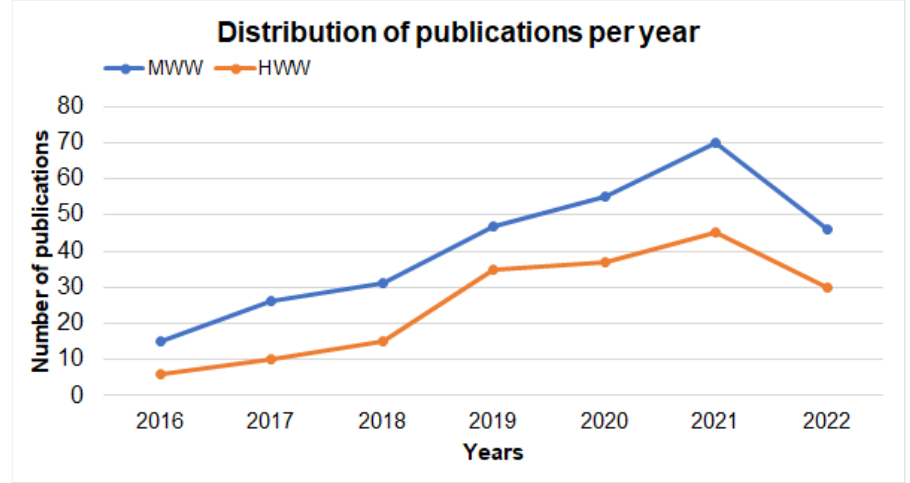
Figure 3. Publications related to techniques for the removal of pharmaceuticals from MWW and HWW. Source: own elaboration.